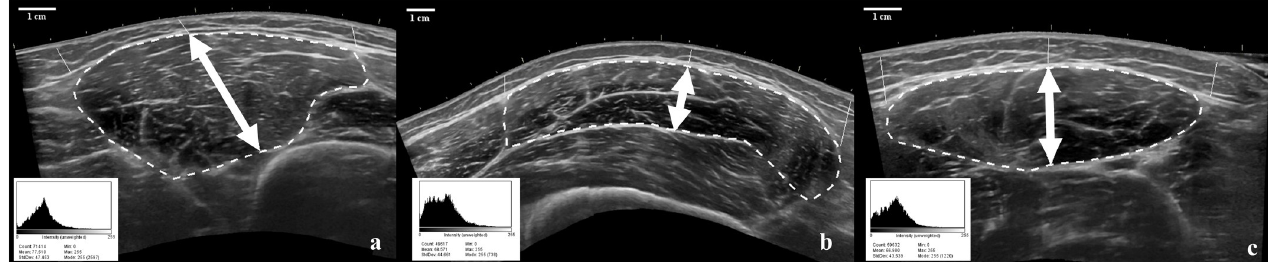
Fig 1. Image analysis parameters for the VM (a), VL (b), and RF (c). The arrows represent MT, straight lines represent subcutaneous fat thickness, and the dotted line represents mCSA. The histogram displays the uncorrected EI (mean) of each image.